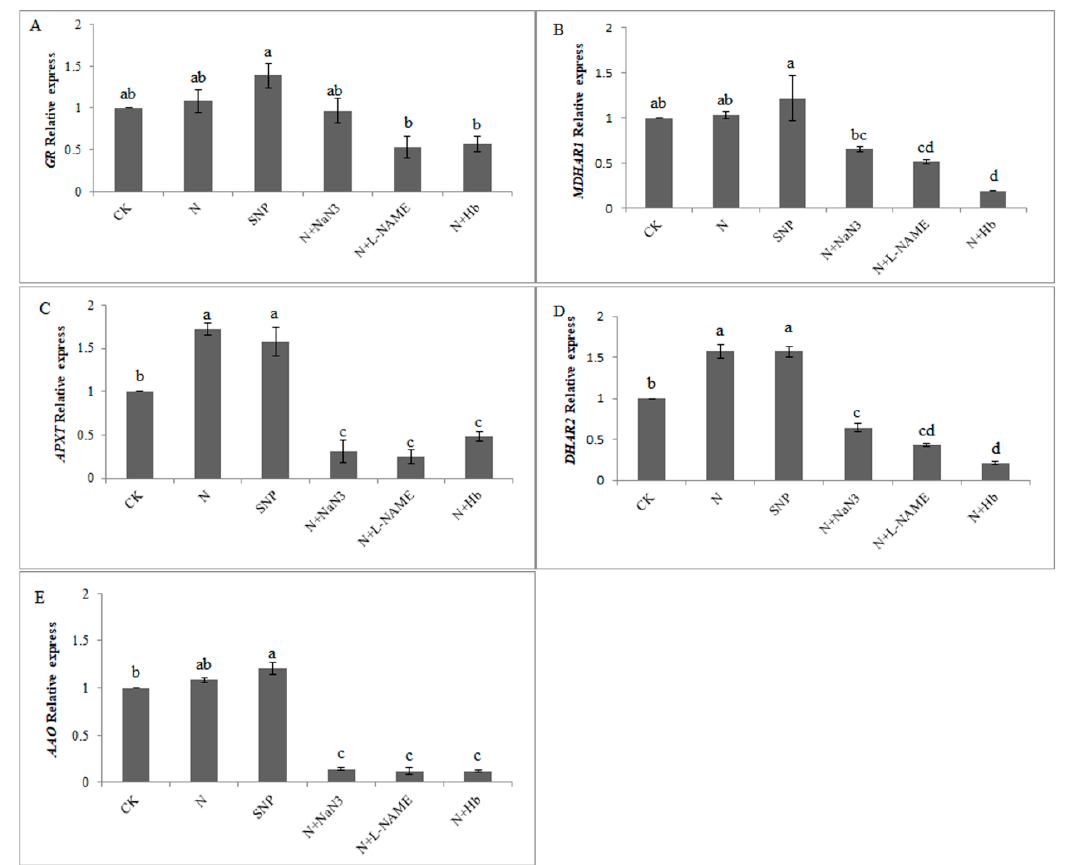
Figure 4. Effects of NO and NH 4+ :NO 3 − ratio on the relative expression level of genes related to ant oxidative enzymes in the AsA-GSH cycle in leaf under low light stress. The seedlings were exposed to the different treatment solutions as described in Figure 1 for 7 d. Capital letters A–E represent the relative expression levels of GR , MDHAR1 , APXT , DHAR2 , and AAO , respectively. Data are the means of three replicates with SE shown by vertical bars. Means followed by the different letters are significantly different according to Duncan’s test ( p < 0.05), for each treated condition.